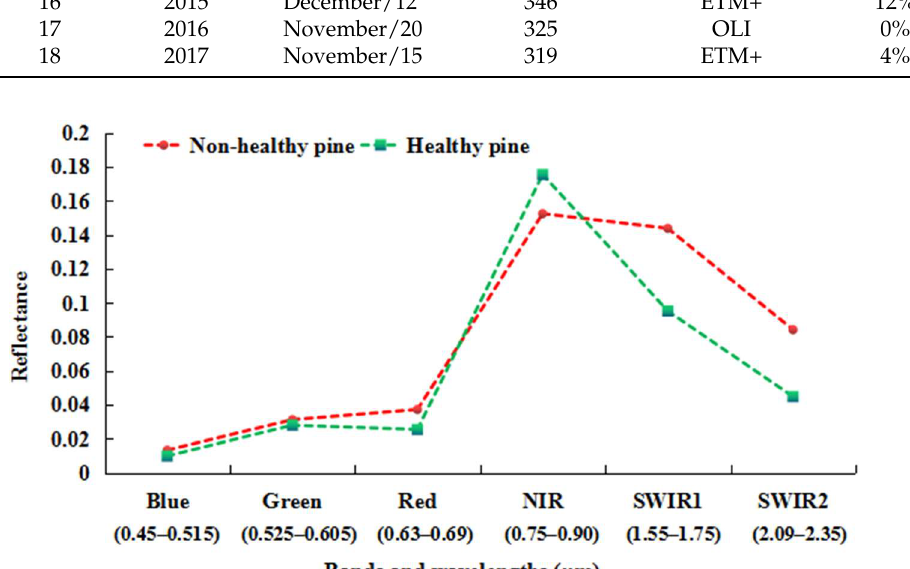
Figure 3. Reflectance values of the non-healthy pine and healthy pine based on the Landsat